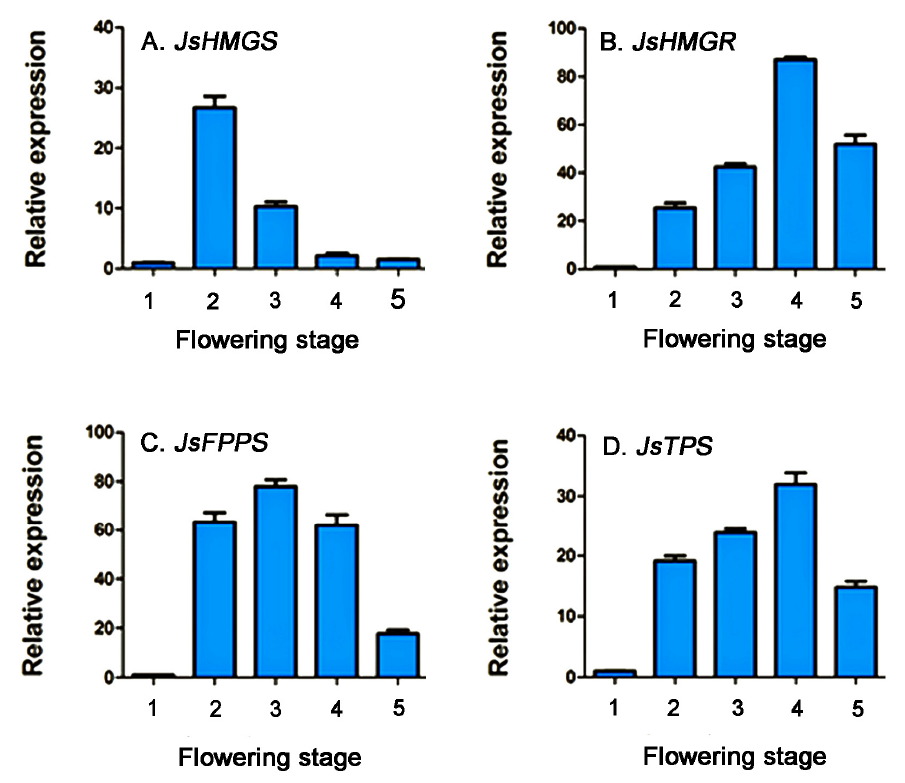
Figure 4. Relative expression of JsHMGS ( A ); JsHMGR ( B ); JsFPPS ( C ); and JsTPS ( D ) genes in living flowers of J. sambac ‘Bifoliatum’ at five flowering stages analyzed using qRT-PCR. The expression levels were normalized based on the expression of internal control gene actin and corresponding genes expressed at the flower bud stage. The bars represent standard errors of three replicates ( n = 3).